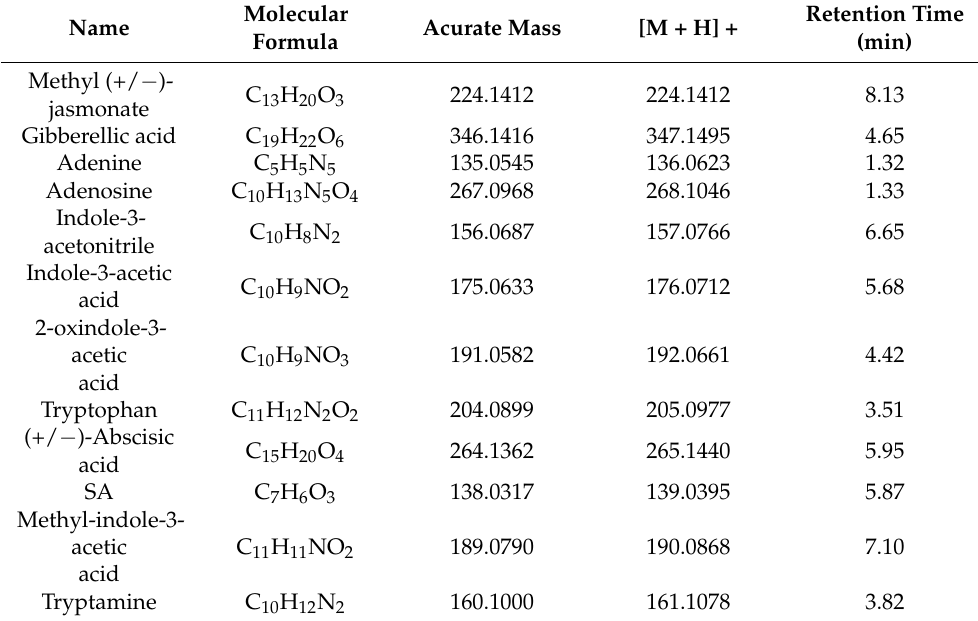
Table 5. The molecular formula, accurate mass, [M + H] + and retention time of individual plant hormones and structural